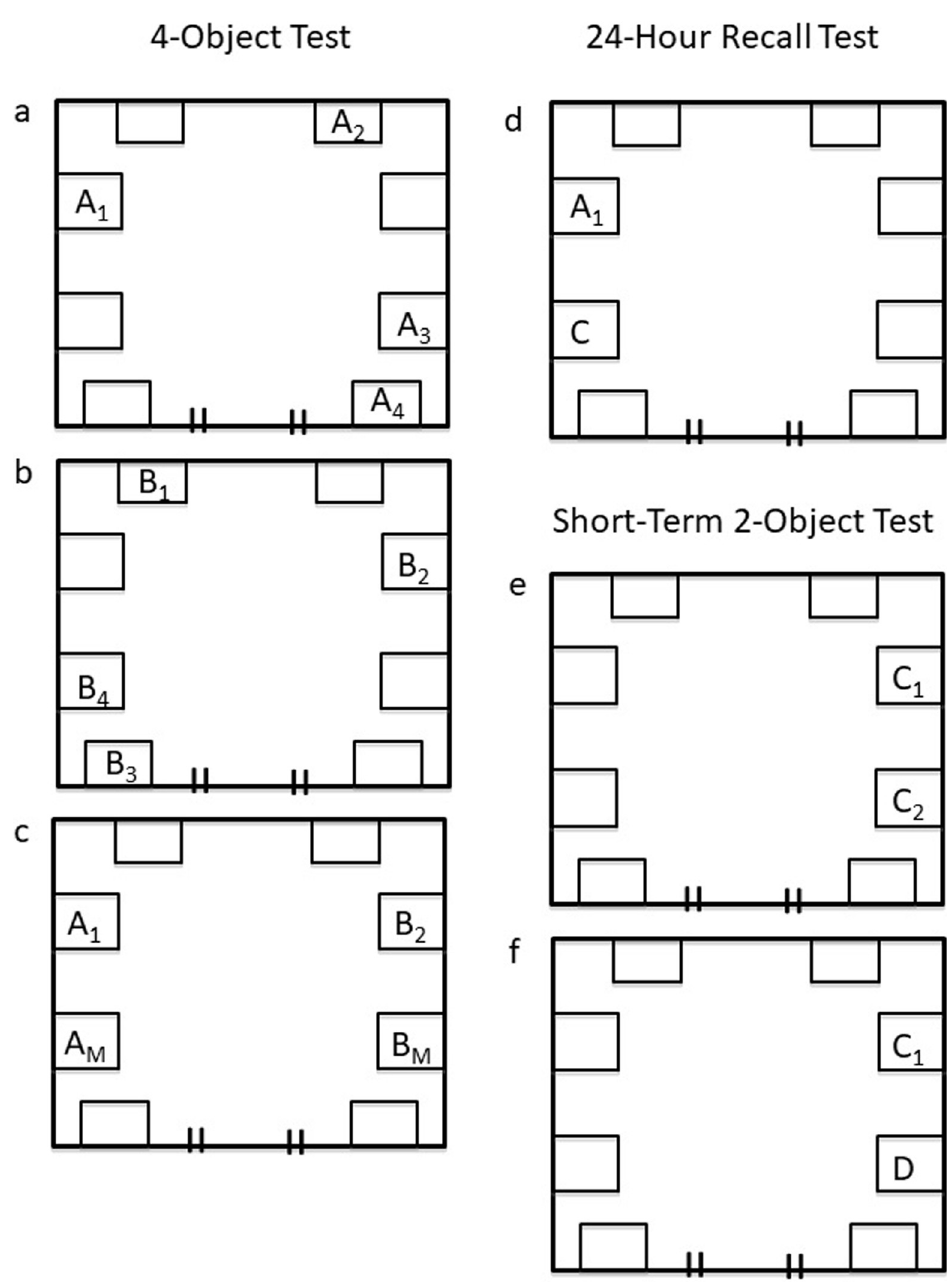
Fig 1. Schematic of testing apparatus. The testing apparatus was a 152 x 152 cm box with a latchable door. The rectangles within the box perimeter represent sites where objects could be attached for pig exploration. Fig 1a-c : 4-Object Test . The initial exposure is represented in (Fig 1a), the second exposure (Fig 1b) and the test exposure (Fig 1c). In (Fig 1c), subscript M denotes that this object has been moved from the previous exposure. Fig 1d : 24-Hour Recall Test . During one episode, pigs were tested to distinguish between novel object C and object A (Fig 1d). Object A 1 was viewed 24-h prior during the 4-object test in Fig 1c. Fig 1e-f : Short-Term 2-Object Test . The initial exposure (Fig 1e) and the test exposure (Fig 1f). In (Fig 1f), the object D is novel.